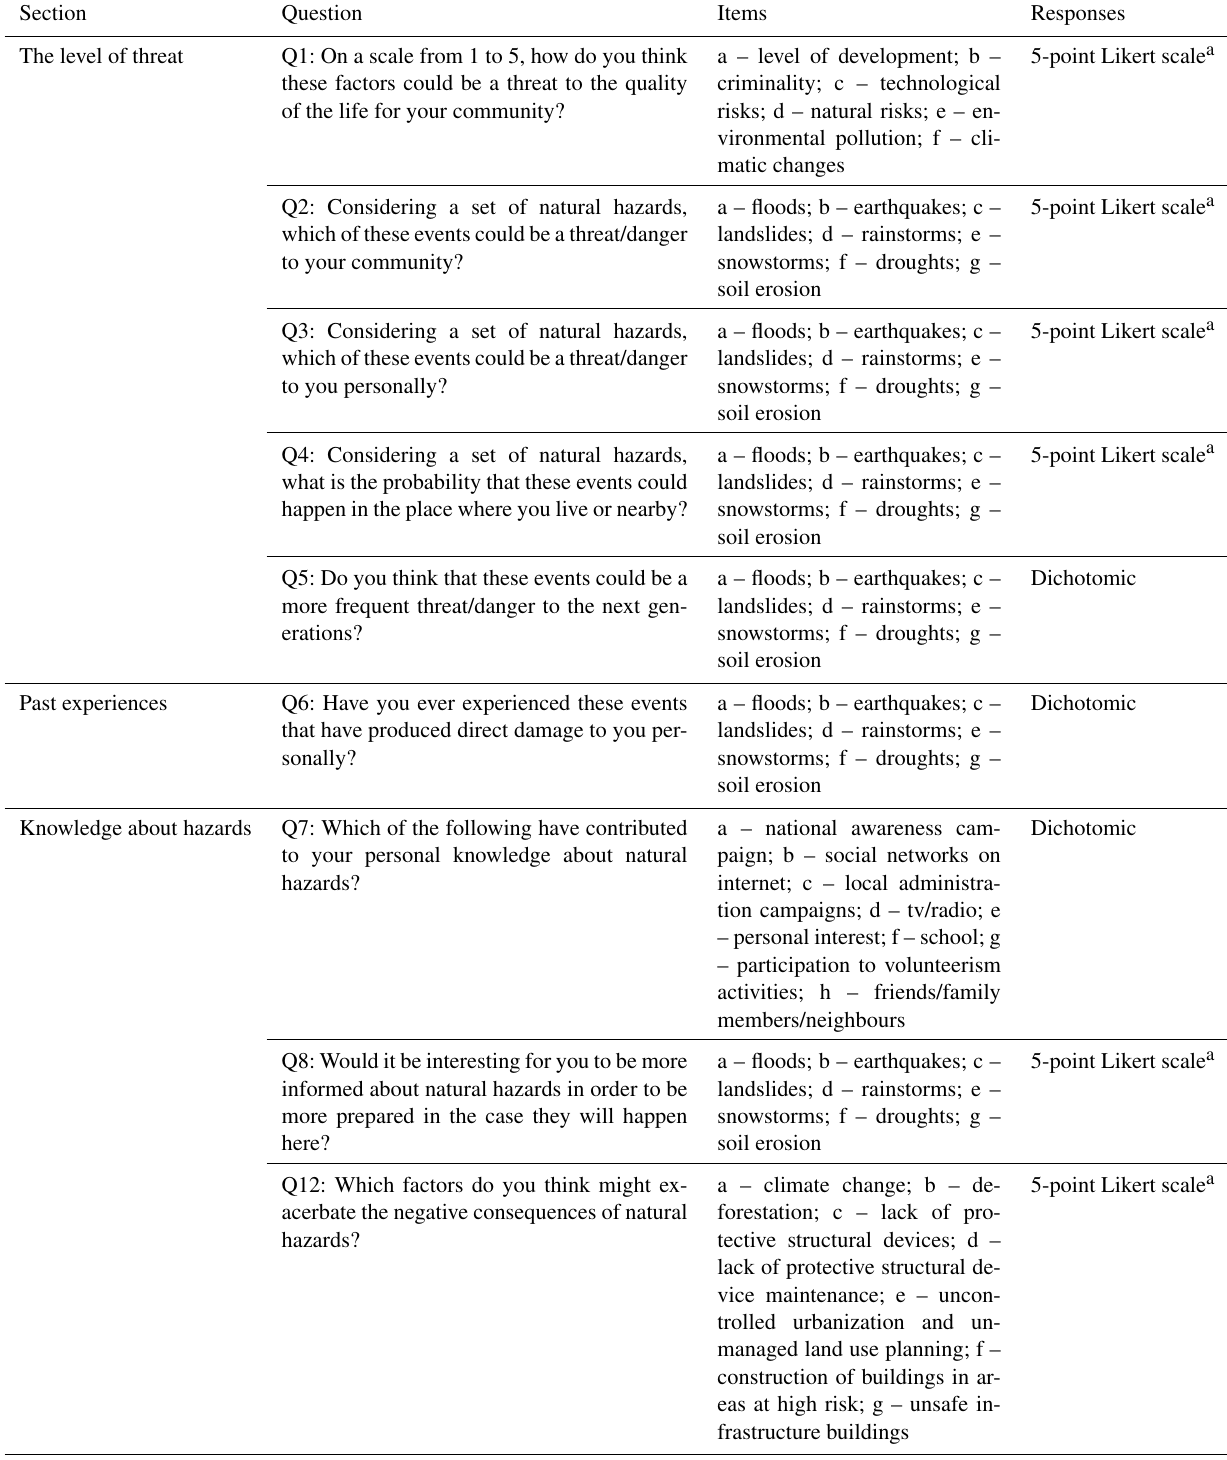
Table A1. Questionnaire sample and variables’ units of